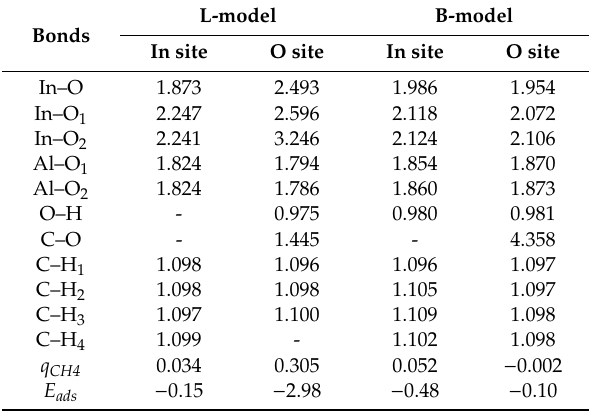
Table 3. Bond length ( d , Å), Mulliken charge population ( q , e), and adsorption energy (E ads , eV) of CH 4 adsorption on In / BEA.